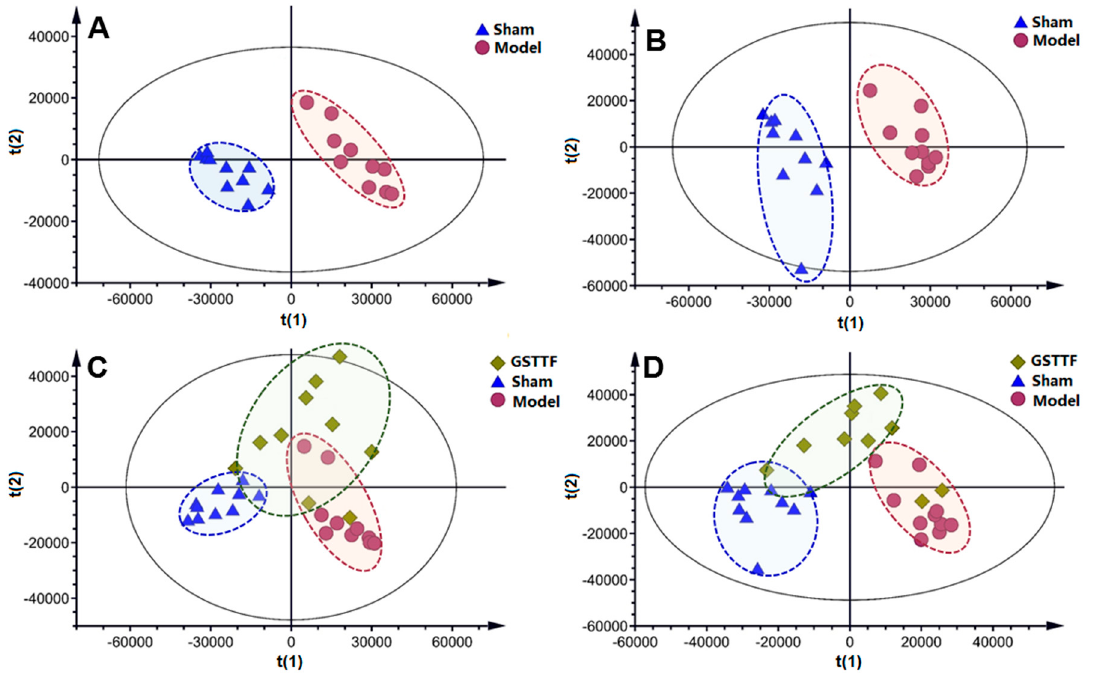
Figure 3. The PLS-DA score plots of the sham group ( ▲ ), model group ( ● ), and GSTTF-treated group ( ◆ ) based on the data acquired in positive ion mode ( A and C ) and negative ion mode ( B and D